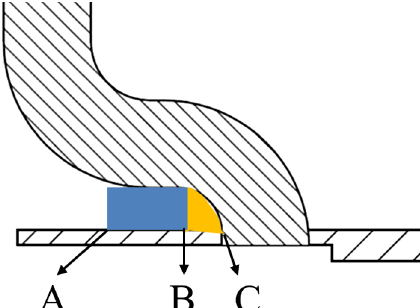
FIG. 14. Space occupied by two-surface MP in Zone 3. MP starts from region A at the onset gradient and moves toward region B with an increasing gradient in ILC, CEBAF, and SNS cavity. For 3.9 GHz original HOM coupler, the MP starts from A and moves toward